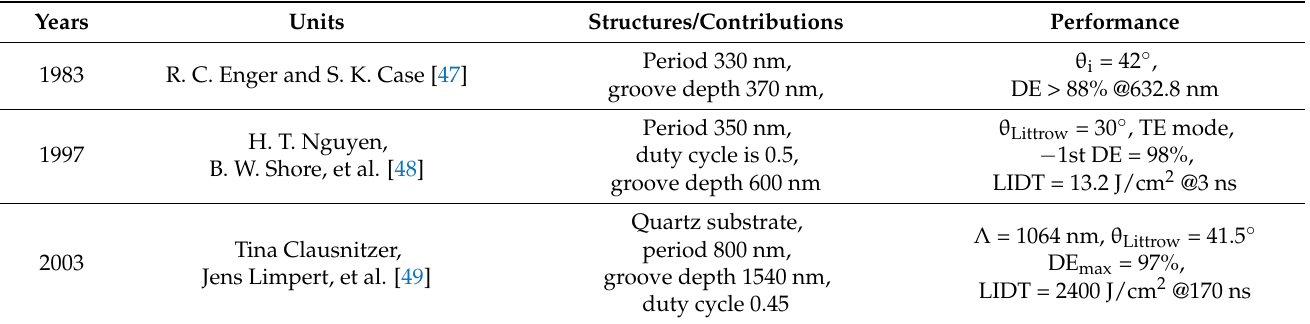
Table 3. Overview of multilayer dielectric transmission gratings in recent years. Units Structures/Contributions